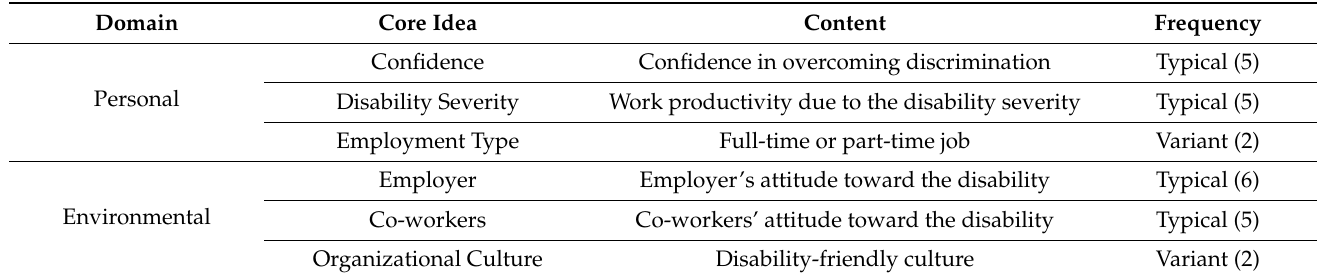
Table 2. Summary of Domains, Core Ideas, Contents, and